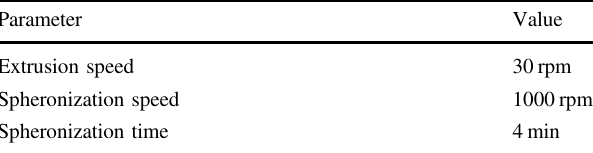
Table 3 The parameter of extrusion-spheronization process of aspirin drug-loaded pellets